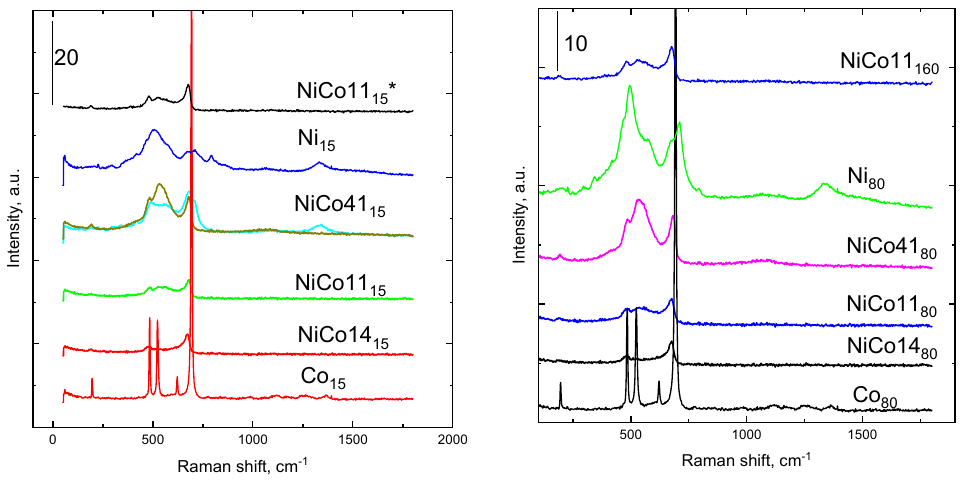
Figure 5. Raman shifts observed with the